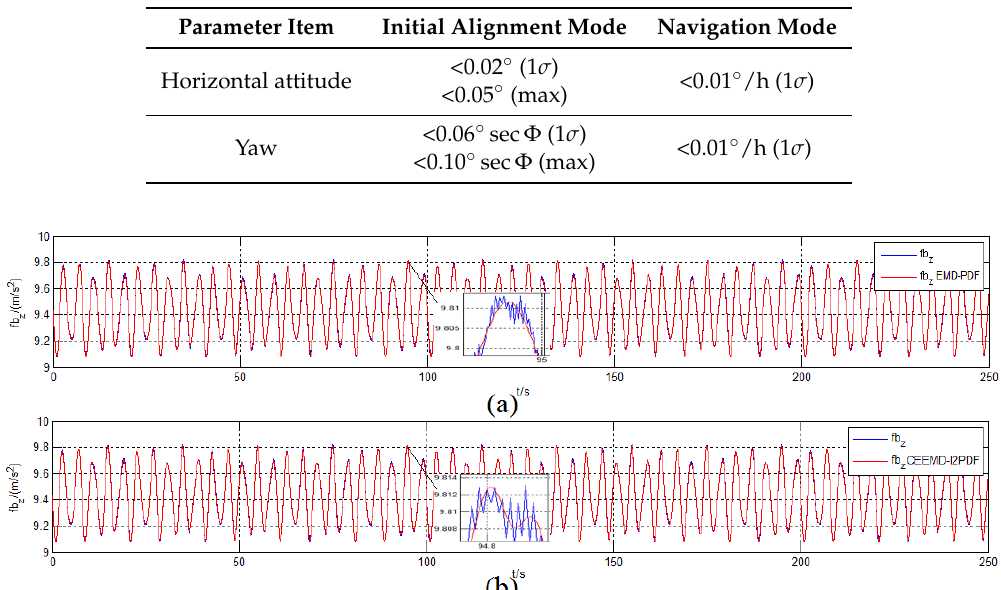
Figure 9. Experimental conditions of the turntable. ( a ) Self-developed SINS. ( b ) Three-axis turntable. Table 4. The parameters of self-developed SINS.